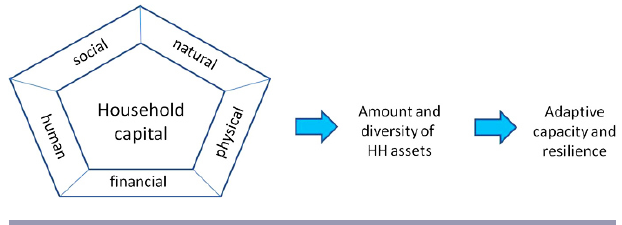
Fig. 1. Schematic diagram showing the five types of household capital that contribute to household adaptive capacity and